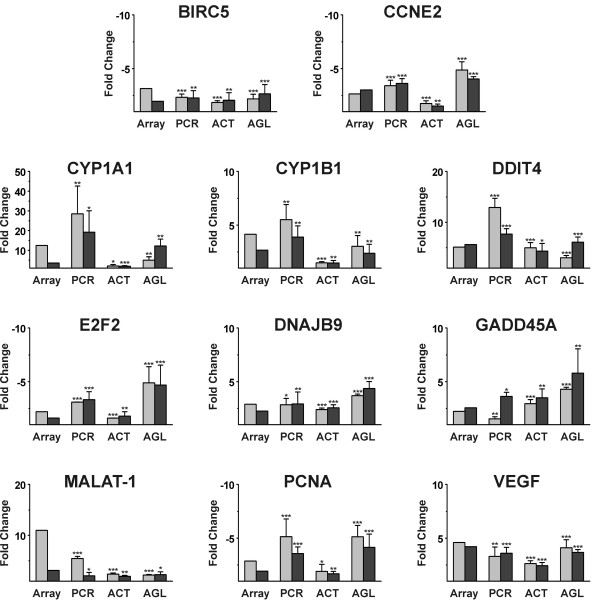
Gene expression levels of selected genes in MCF-7 cells after 24 h treatment with black cohosh extract (15 μg/ml), the triterpene glycoside actein (20 μM) or the triterpene aglycon mixture (30 μM). For extract treatment results obtained with microarrays (Array) and real-time RT-PCR (PCR) are shown. For actein (ACT) and the aglycons (AGL) expression levels were determined by real-time RT-PCR. Bars represent gene expression levels as fold changes calculated versus DMSO control. RT-PCR measurements were done at least in triplicate. The data are presented as means ± SD (*p < 0.05, **p < 0.01, ***p < 0.001: gene expression statistically significantly different from DMSO control, calculated by Student's t-test).